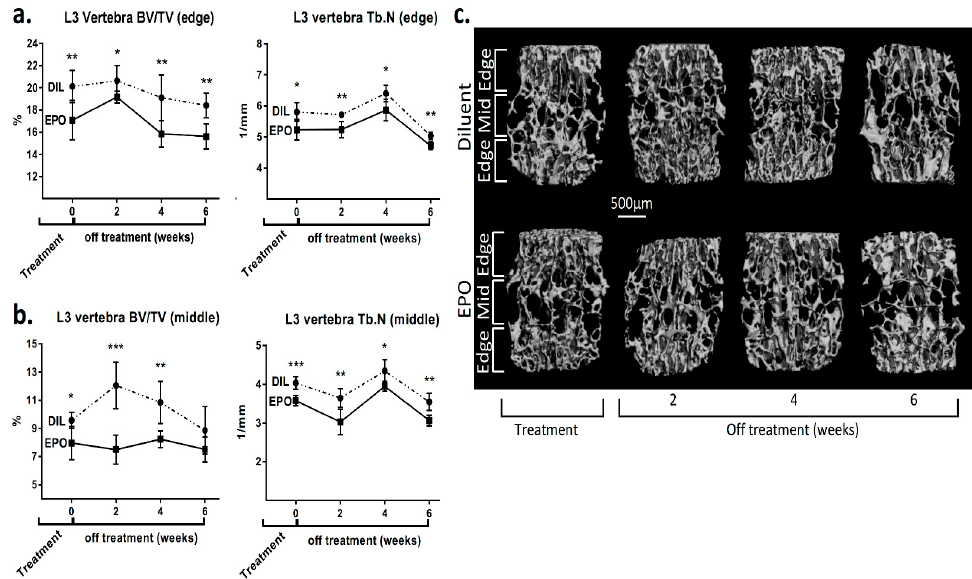
Figure 5. EPO induces irreversible changes in the microarchitecture of the lumbar spine vertebrae. a. Trabecular bone volume (BV / TV) and trabecular number (Tb.N) of the edge ( a ) and midportion ( b ) of the L3 vertebra from diluent (DIL) and EPO (540 IU / week)-treated female mice at the completion of the treatment period and 2, 4 and 6 weeks post treatment. Values are mean ± SD. *** p < 0.001; ** p < 0.01; * p < 0.05; c. Representative 3D reconstruction images of the L3 vertebra (subdivided into edge- and midportions) of the mice described in (a) and (b). n = 6 for each group. “Edge” and “middle” portions of the vertebral body were defined as marginal (upper/lower) and middle 1/3 of the vertebral body in the axial plane.